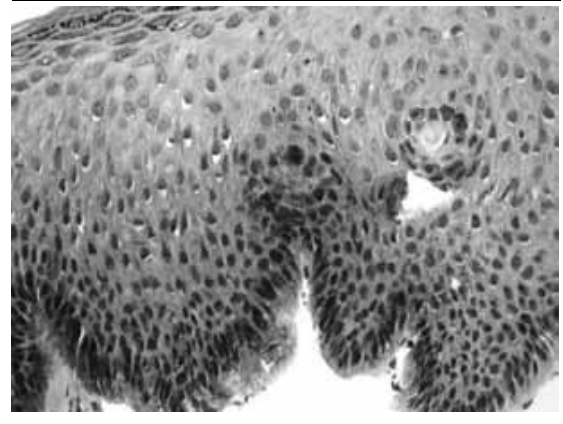
figurE 3 – Magnified image of squamous mucosa of the uterine cervix with hyperpigmentation of basal layer cells without increase in melanocytes (HE, 200×) HE: hematoxylin and eosin.